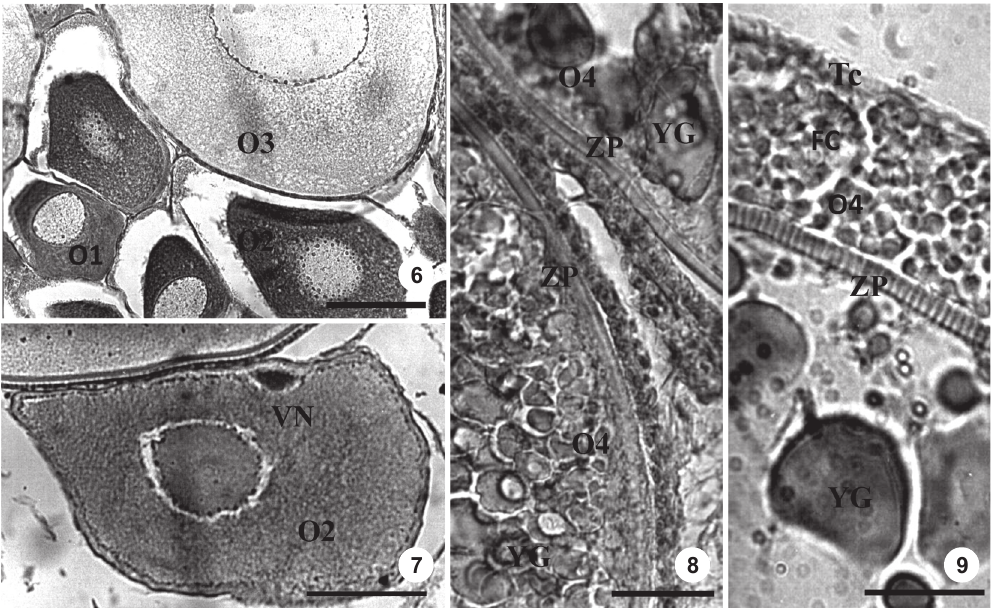
Figures 6-9. Cross section of the ovarians of H. affinis showing different phases of oocyte development, stained by Hematoxilin-Eosin: (6) initial maturation with young oocyte (O1) and previtellogenic oocyte (O2) and vitellogenic oocyte (O3); (7) previtellogenic oocyte (O2) with vittelinic nucleous (VN) in the region peripheric of cytoplasm; (8-9) oocyte O4 in showing the zone pellucid ou radiate (ZP), yolk globules (YG), follicular cells (FC) and teca (Tc). Scale bars: 6 = 50 µm, 7 = 120 µm, 8 = 320 µm, 9 = 160 µm.